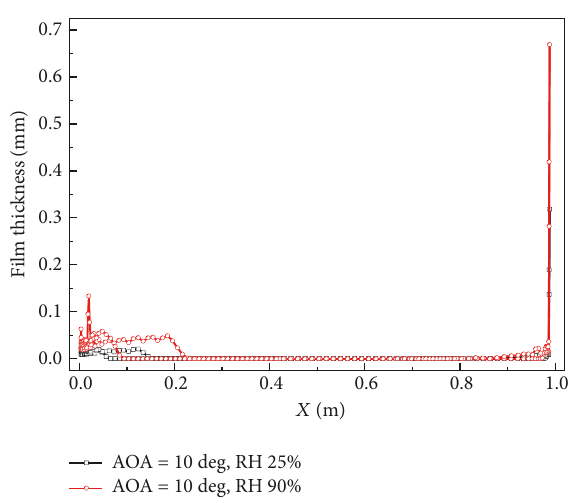
Figure 14: Contour plots of film thickness on airfoil for AOA = 10 degrees (EWF model).